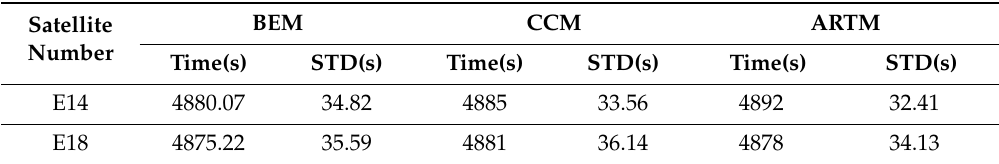
Table 1. The mean shift time and STD for GAL E14 and E18 satellites, which was calculated by the three methods during DOY:161–191, 2018.